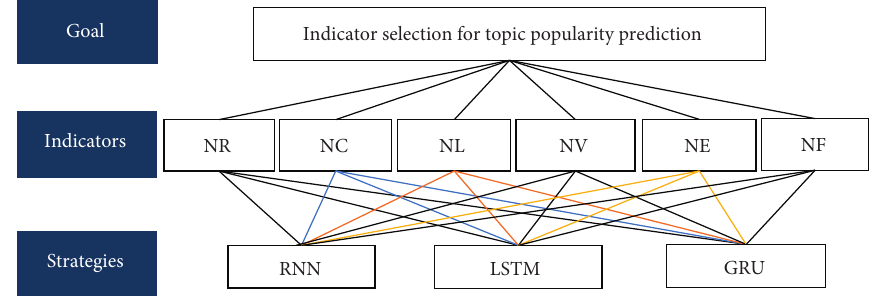
Figure 6: AHP-based indicator selection model for topic popularity prediction. Table 4: Pairwise comparison judgment matrix of the indicator layer.